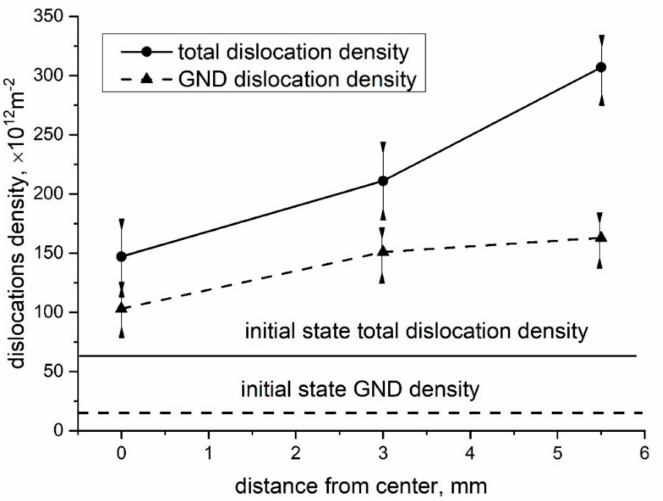
Figure 7. Dislocation density distribution in the CP Cu rod before and after